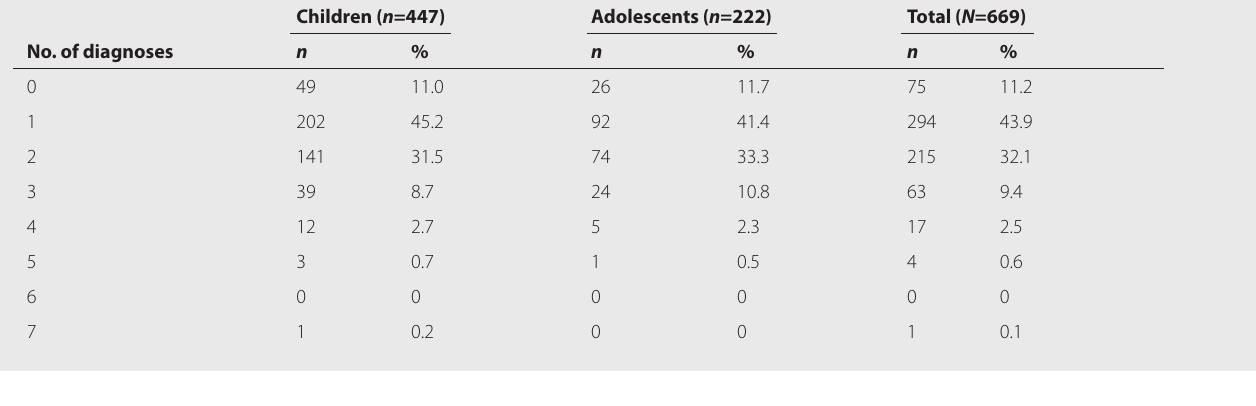
Table 2. Number of diagnoses made in children and adolescents seen at the Child and Adolescent Unit of the FSPC from January 2006 to December 2007